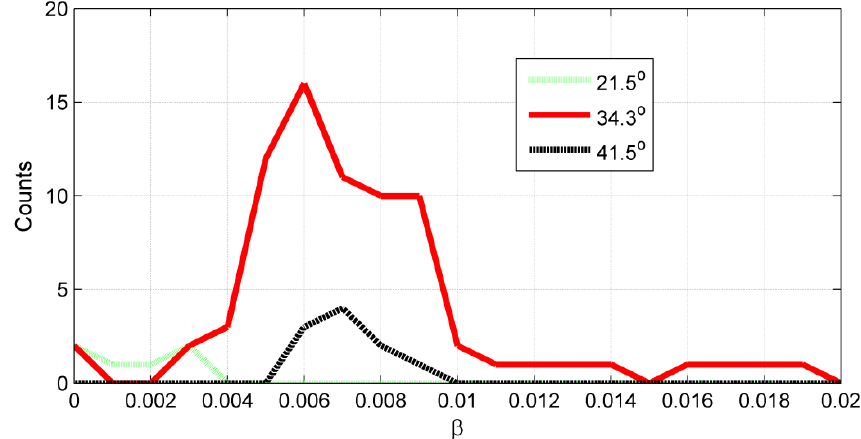
Figure 6. Histograms of the estimates of the model parameter β at Krycklan as a function of look angle.